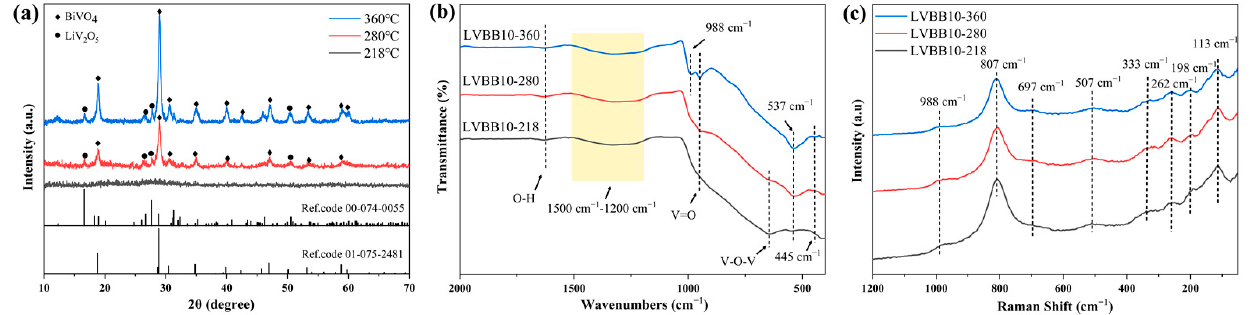
Figure 5. ( a ) XRD patterns, ( b ) infrared spectra and ( c ) Raman spectra of LVBB10 glass material after heat treatment at different temperatures. The ball-milled LVBB10 glass powder was heat-treated in a tube furnace with argon atmosphere for 12 h at 218 °C, 280 °C, and 360 °C, respectively. The FE-SEM images of LVBB10, VBB10-218, LVBB10-280, and LVBB10-360 are shown in Figure 6. Figure 6a,b show that the LVBB10 and VBB10-218 particles have irregular shapes and relatively rough surfaces; when the heat treatment temperature is further increased, the surfaces of LVBB10-280 and LVBB10-360 particles shown in Figure 6c,d become relatively smooth, implying that the internal structure of LVBB glass may have changed after heat treatment at higher temperatures, which is consistent with the XRD results.